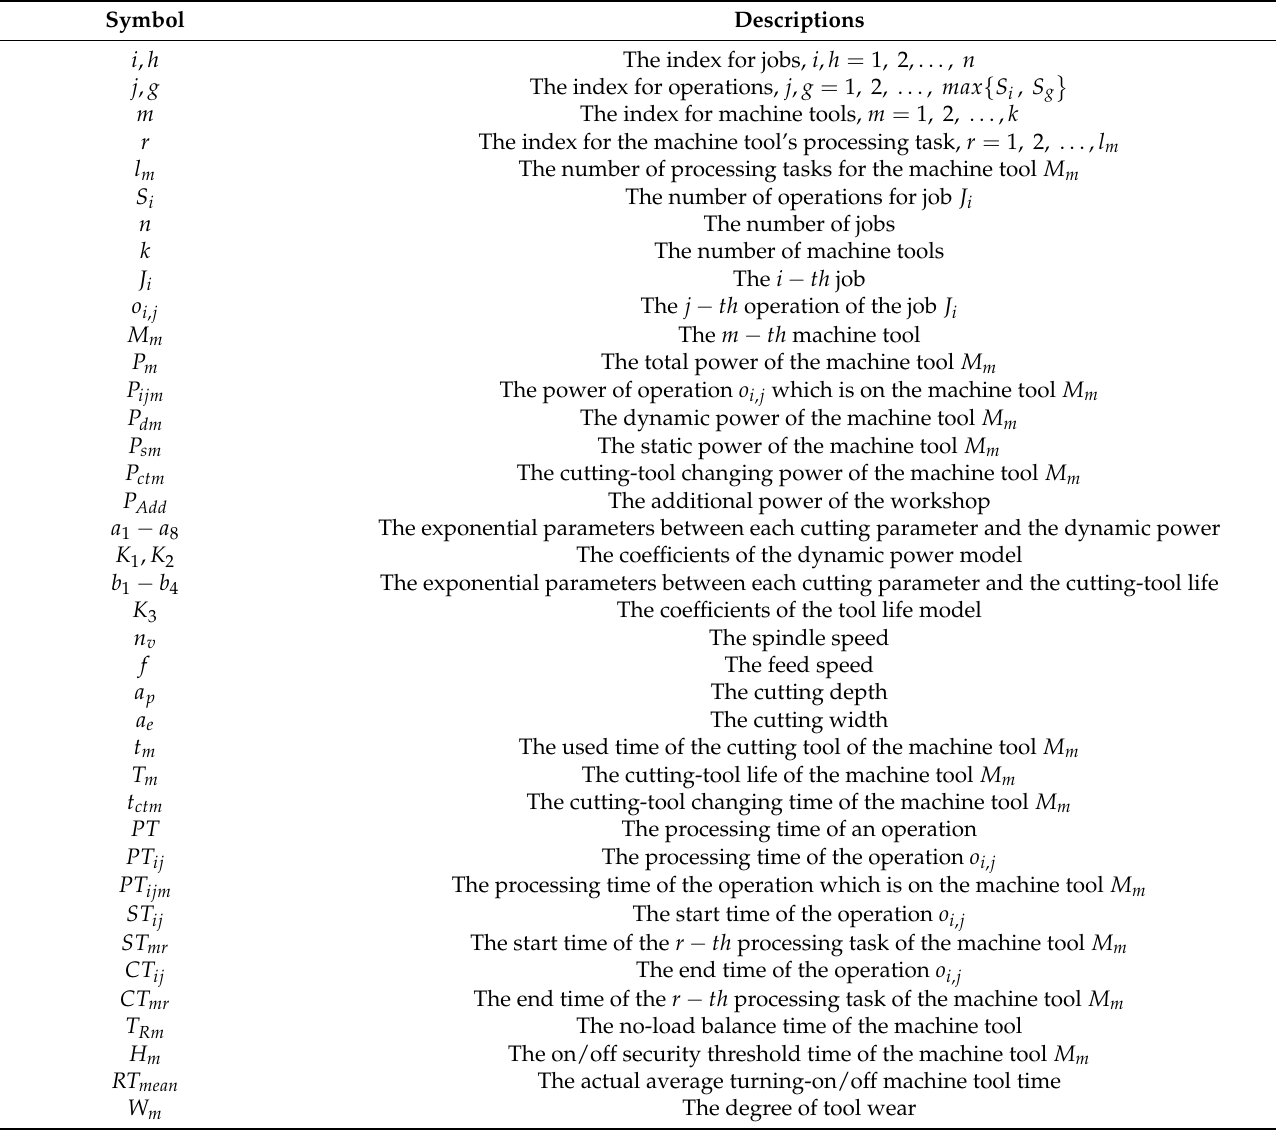
Table 1. The symbols used in this